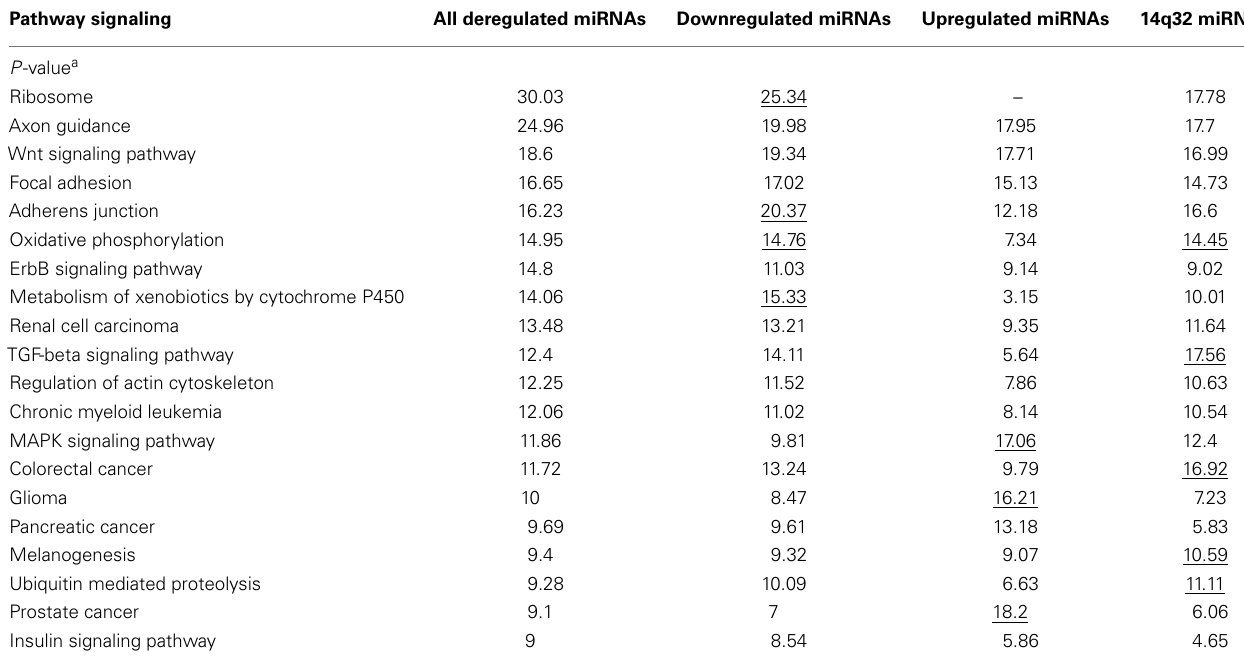
Table 5 |Top 20 pathways predicted by DIANA-miRPath